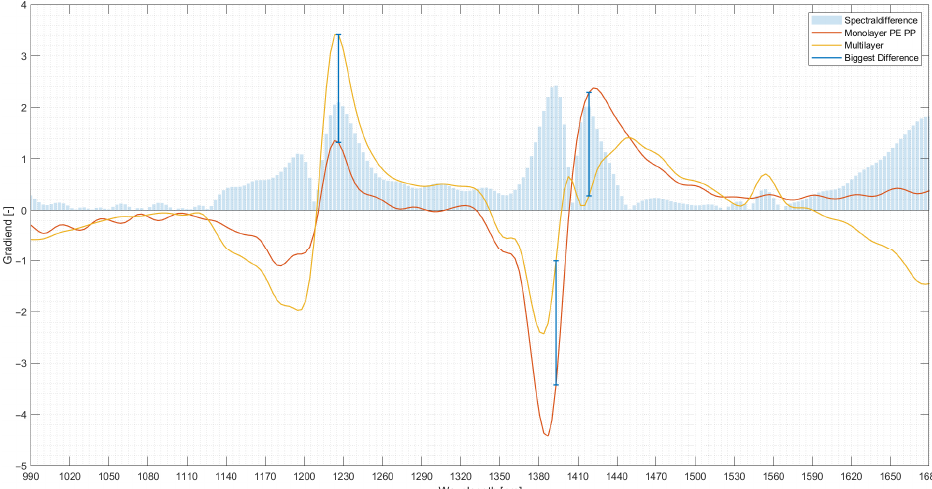
Figure 21. Differences in the mean spectra of multilayer and monolayer materials.